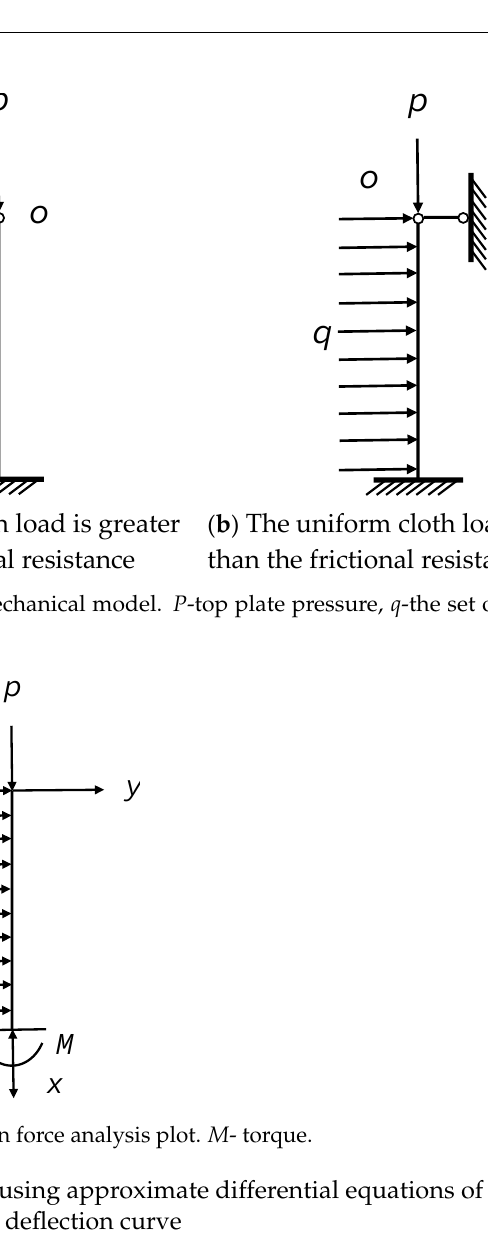
Figure 5. Either x-section force analysis plot. M - torque.